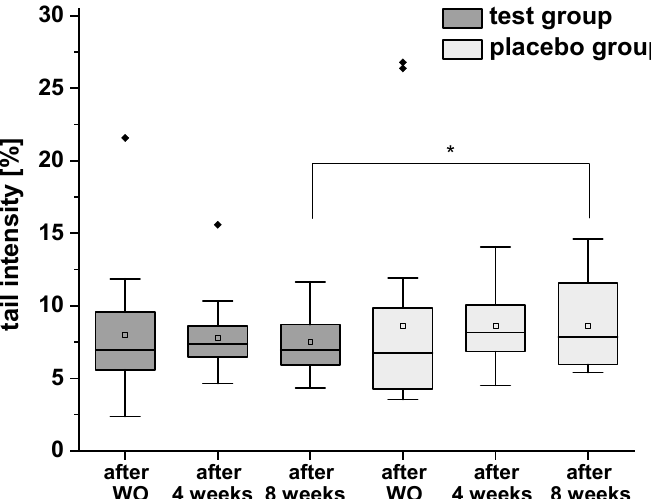
Figure 4. The background and total DNA strand breaks in whole blood during the nine-week study: ( a ) test group (n = 18), ( b ) placebo group (n = 18). Data are expressed as mean tail intensity [%] ± SD. Significant differences in comparison to the washout period: * p < 0.05.